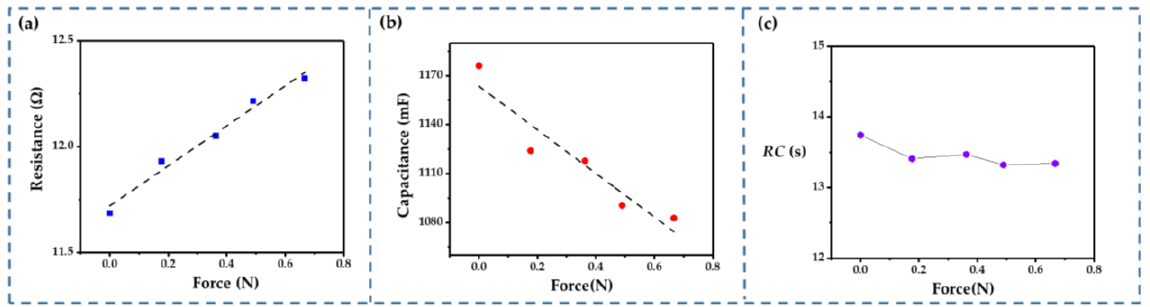
Figure 14. Test results: ( a ) resistance vs. external force. ( b ) capacitance vs. external force. ( c ) RC vs. external force.